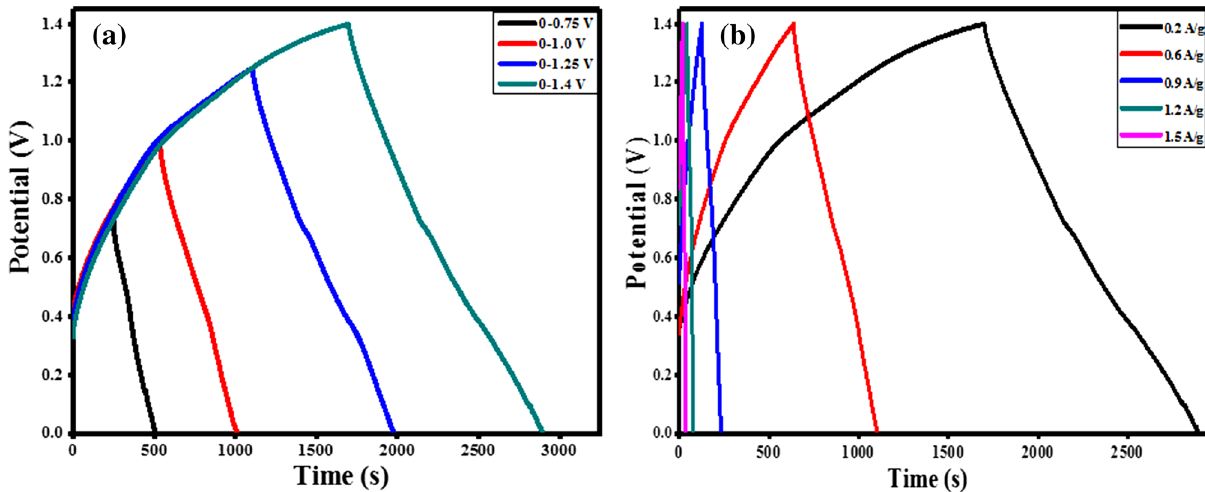
Figure 7. GCD plots of G-NiO//AC supercapattery measured at ( a ) different potential windows, and ( b ) different current